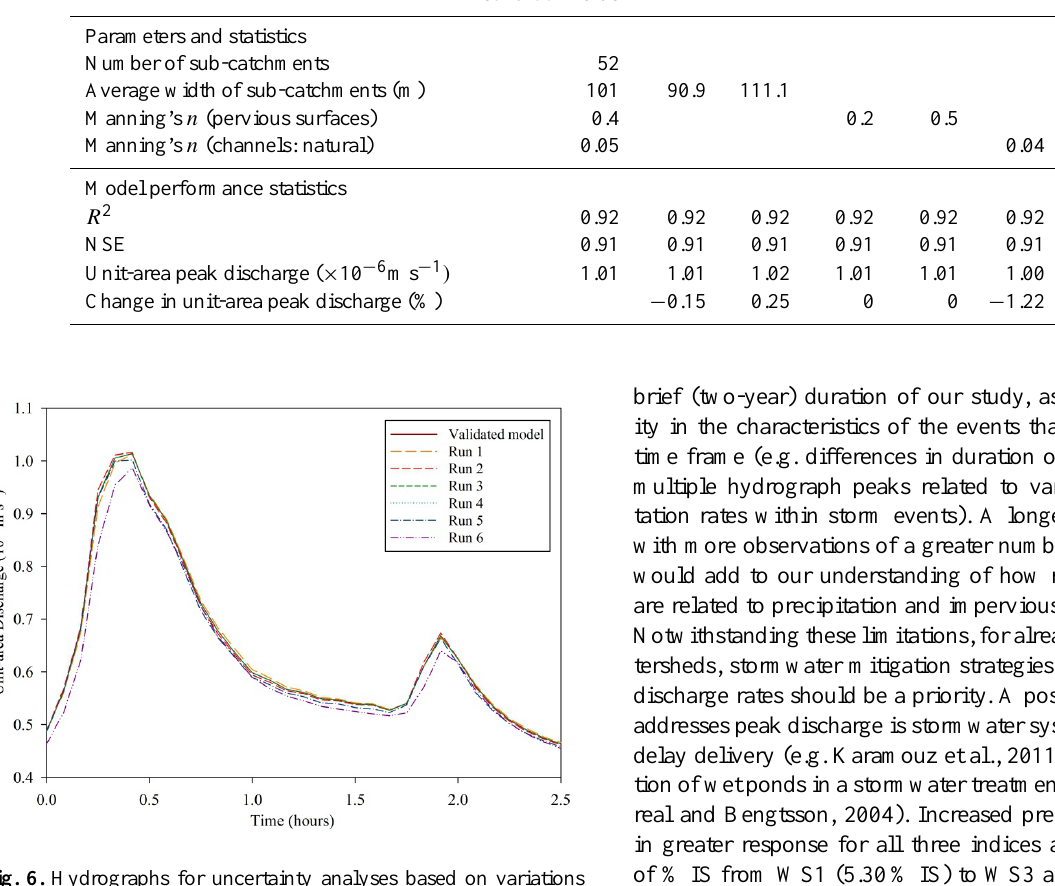
Fig. 6. Hydrographs for uncertainty analyses based on variations in sub-catchment width and Manning’s n (impervious surface and natural channels) for WS4.